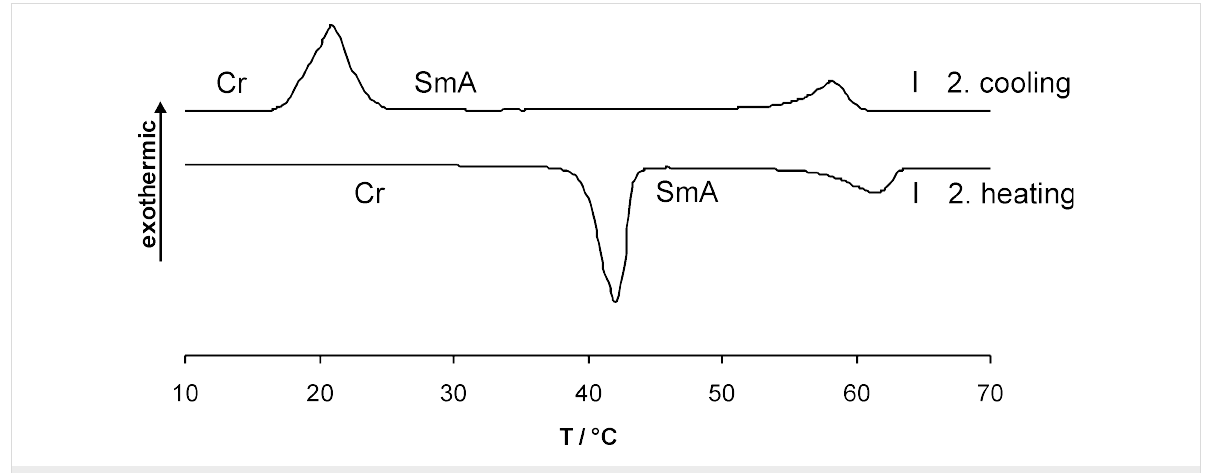
Figure 1: DSC curve of compound 3d (heating/cooling rate 10 K/min).